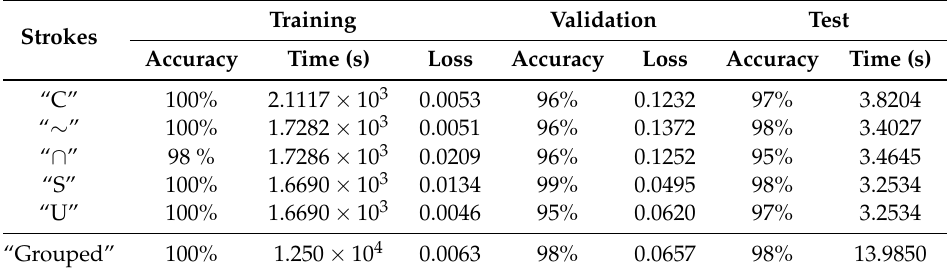
Table 9. Original Simple Grapheme - VGG-16 (epoch = 50).